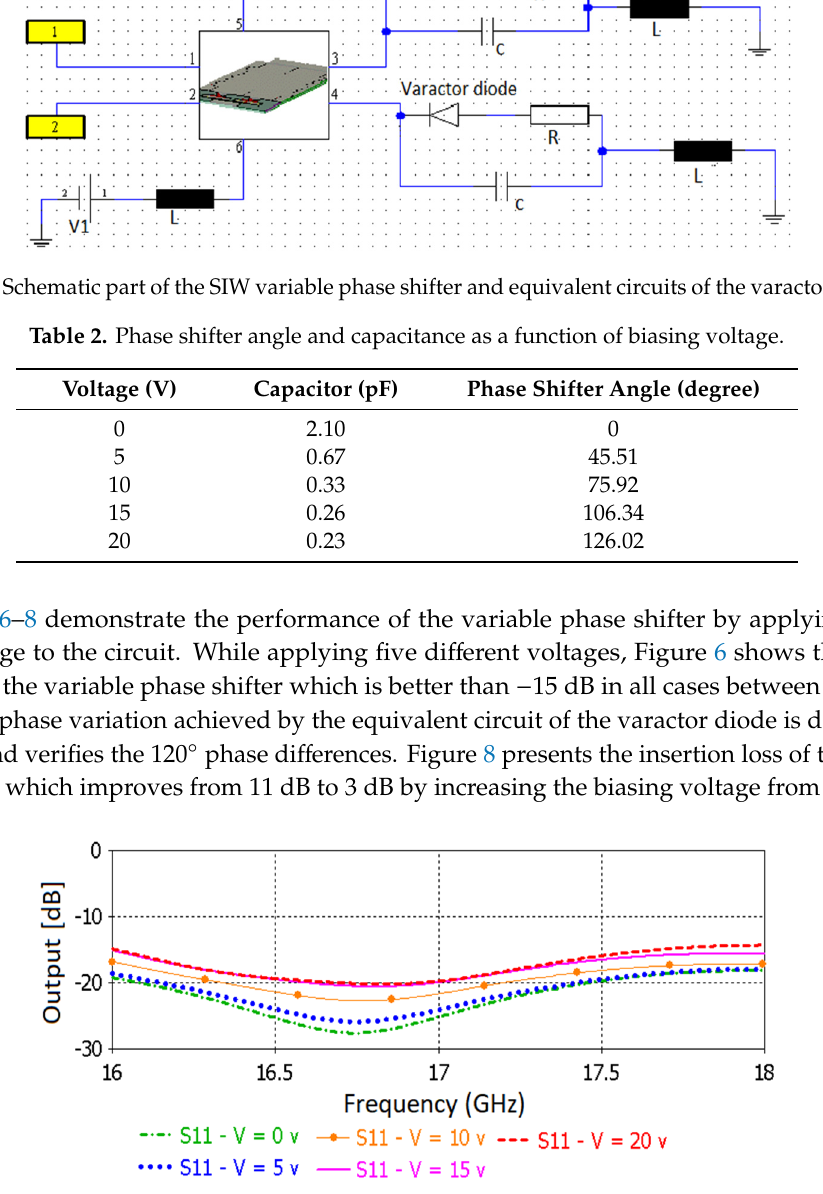
Table 2. Phase shifter angle and capacitance as a function of biasing voltage.